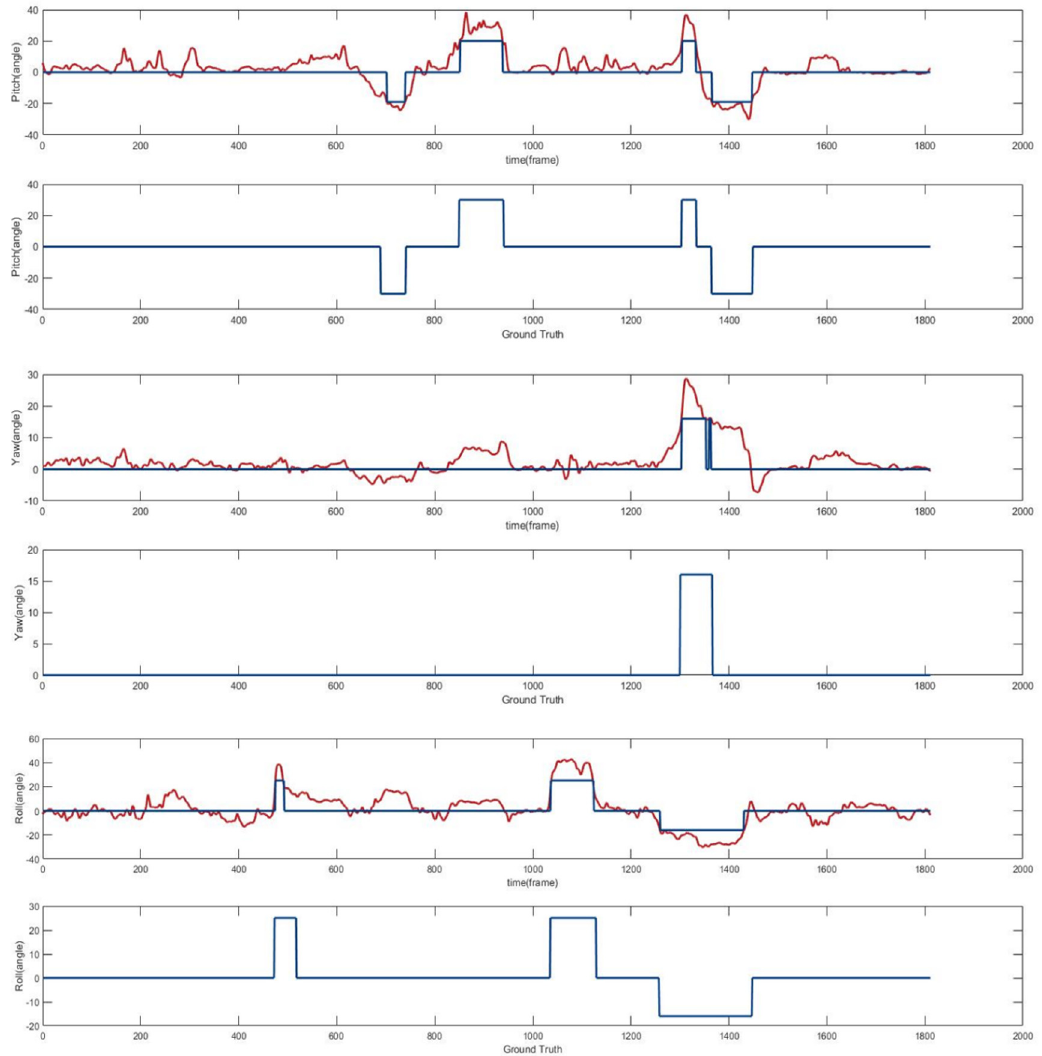
Figure 9. The above figure shows the results of using the angle analysis video in this section. There are six graphs, from top to bottom, in Figure 9. The red curve of the first graph is the pitch output by EPnP. The blue line segment is binarized using the pitch over-angle. If it exceeds the over-angle, the pitch is too deflected. The second graph is the ground